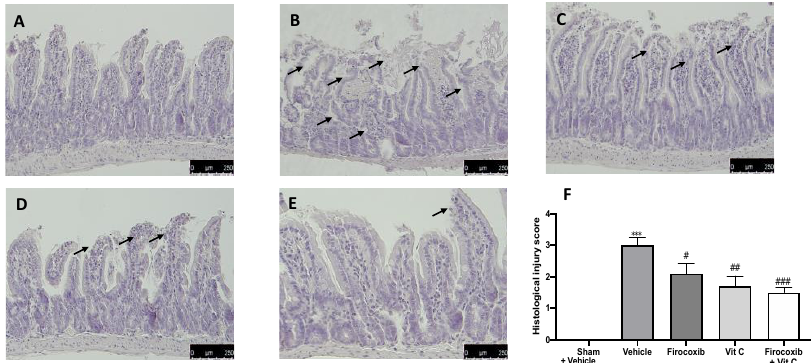
Figure 5. Effect of combined therapy of firocoxib and vitamin C on I/R-induced intestine injury and MPO activity: hematoxylin and eosin (H&E) staining: ( A ) sham + vehicle, ( B ) vehicle, ( C ) firocoxib, ( D ) vitamin C, ( E ) Firocoxib+Vit C, ( F ) histological injury score. n = 5 animals from each group for each analysis. A p -value of <0.05 was considered significant; # p < 0.05 vs. vehicle, ## p < 0.01 vs. vehicle, *** p < 0.001 vs. sham + vehicle, and ### p < 0.001 vs. vehicle.